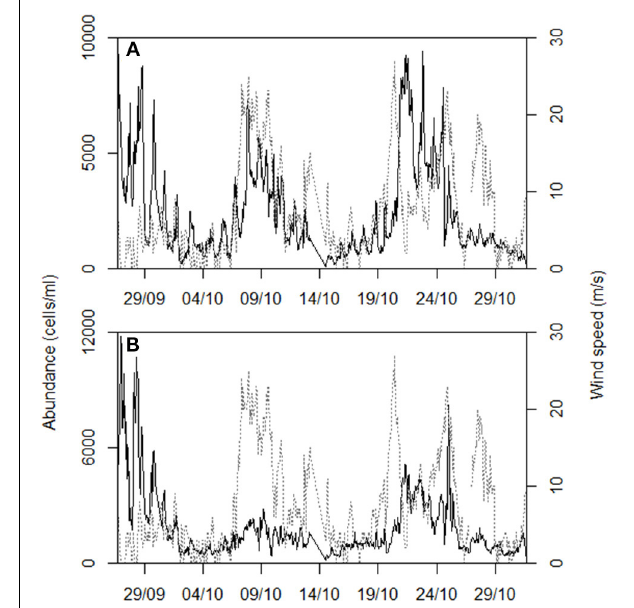
FIGURE 8 | Principal component analysis performed on the dataset. Projection of the observations (gray points, i.e., dates from 10/05/11 00:00 to 10/11/11 23:00) and the variables (arrows, i.e., hydrological variables and clusters abundance) on the two first principal components of the PCA (59.1 % of the total variance).